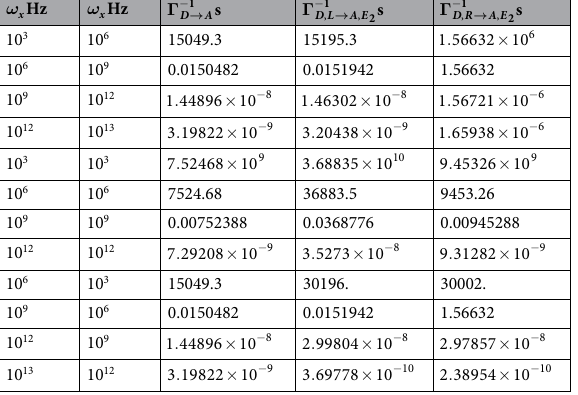
Table 1. Elastic and inelastic ET rates for some parameters of the chiral odorants at biological temperature T = 310 K